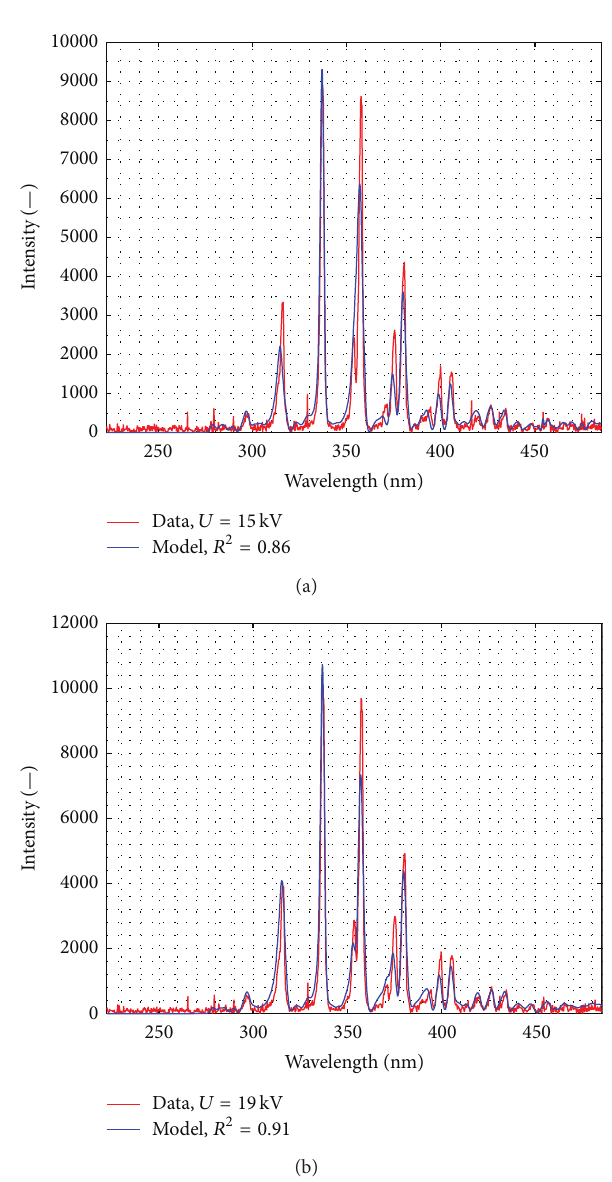
Figure 4: Intensity spectra of recorded and modeled light emission for selected values of PD generation voltages: (a) 0.75 𝑈 𝑝 = 15kV and (b) 0.94 𝑈 𝑝 = 19